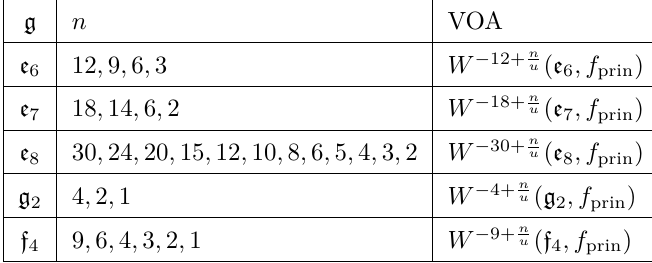
Table 16 . Lisse W-algebras defined using exceptional Lie algebras. Here u is coprime with n .